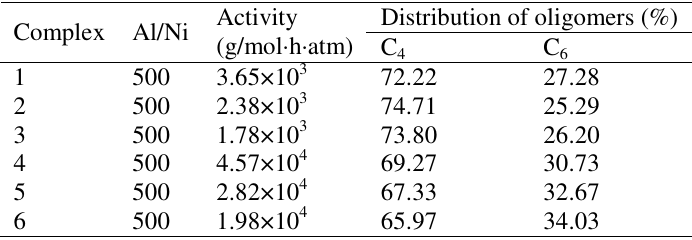
Table 1 . Activity and Distribution of the Oligomerization a